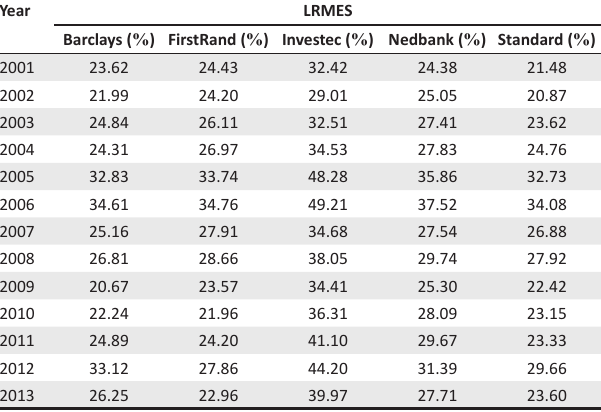
TABLE 3: Long-run marginal expected shortfall of each South African bank. Year